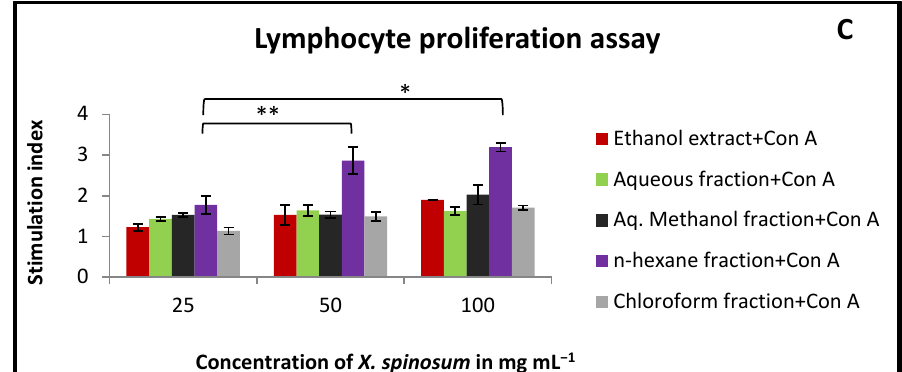
Figure 6. The effect of X. spinosum extract and its fractions on the proliferation of lymphocytes extracted from mouse spleen at the concentration range of (25–100 mg mL − 1 ). ( A ) In the absence of mitogens); ( B ) with (4 μ g mL − 1 ) of LPS; ( C ) with (5 μ g mL − 1 ) of Con A. Results are summarized as means (bars) ± SEM (lines). Stimulation index = stimulated cells (treated)/non-stimulated cells (control). (* p = 0.005) (** p = 0.01) (*** p = 0.004). The results of the other treated groups were insignificant ( p > 0.05) compared to the control.